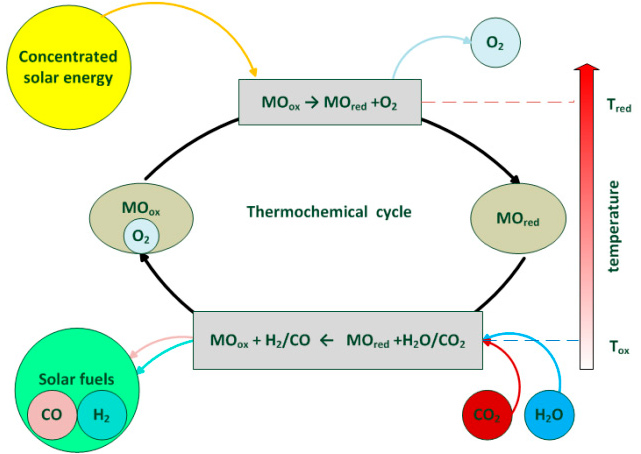
Figure 3. Metal oxide reduction-oxidation (Redox) reaction to produce synthesis gas, figure derived from [23].